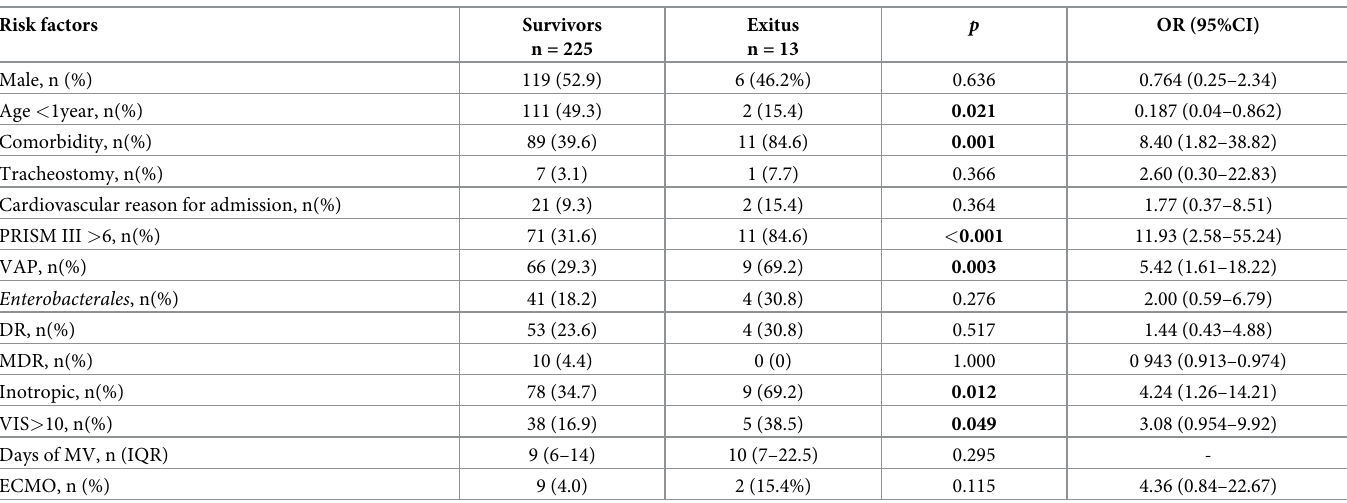
Table 3. Univariate analysis of the risk factors of